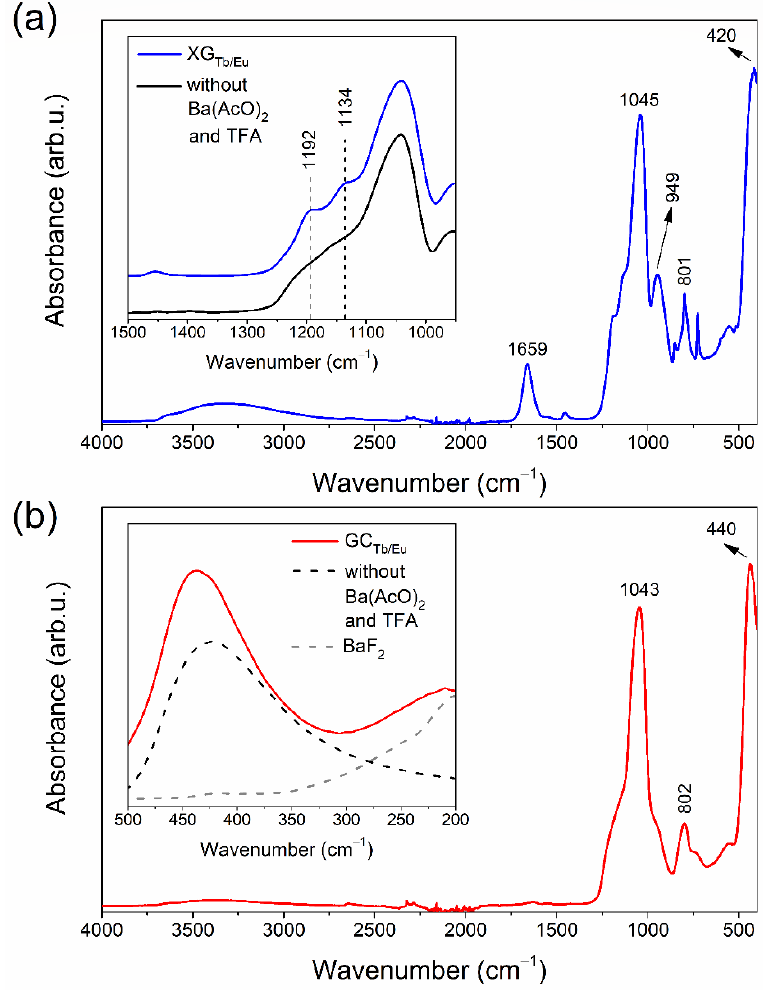
Figure 3. ATR-IR spectra recorded for xerogel XG Tb/Eu ( a ) and nano-glass-ceramic nGC Tb/Eu ( b ) co-doped with Tb 3+ , Eu 3+ ions.